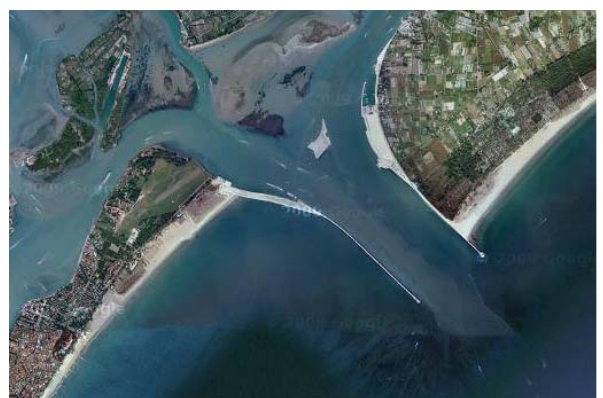
Figure 13 – The Lido inlet to the Venice lagoon. The length of the jetties is about 2 km. Fig. 13. The Lido inlet to the Venice lagoon. The length of the jetties is about 2km.